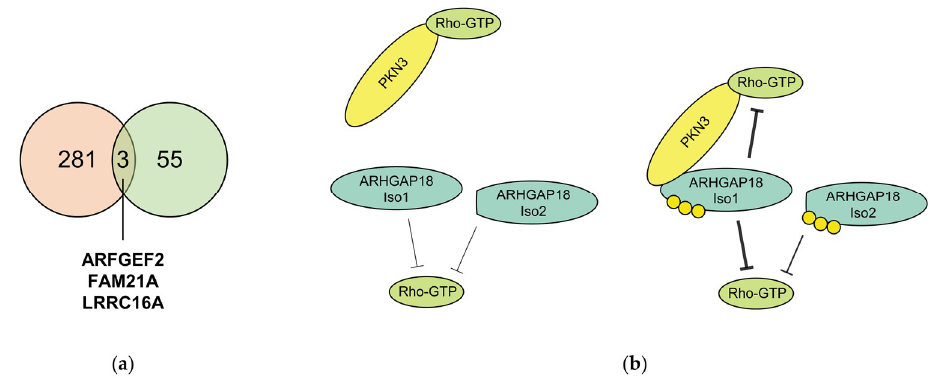
Figure 6. ( a ) Venn diagram representing the overlap between the proteins identified as putative PKN3 substrates in this study (orange) and the phosphoproteomic data presented in Browne et al., 2019 (green) [35]. Three genes were identified in both datasets: ARFGEF2, FAM21A and LRRC16A. ( b ) A model proposing PKN3-mediated regulation of ARHGAP18 activity. ARHGAP18 in its unphosphorylated form exhibits low GAP activity and its N -terminus is potentially sterically blocked and therefore inaccessible for interactions. ARHGAP18 phosphorylation (yellow circles) by PKN3 induces structural change leading to activation of GAP domain and in case of ARHGAP18 Iso1 also to great strengthening of ARGAP18 and PKN3 interaction mediated by the release of its N -terminus which becomes accessible for interaction with PKN3.